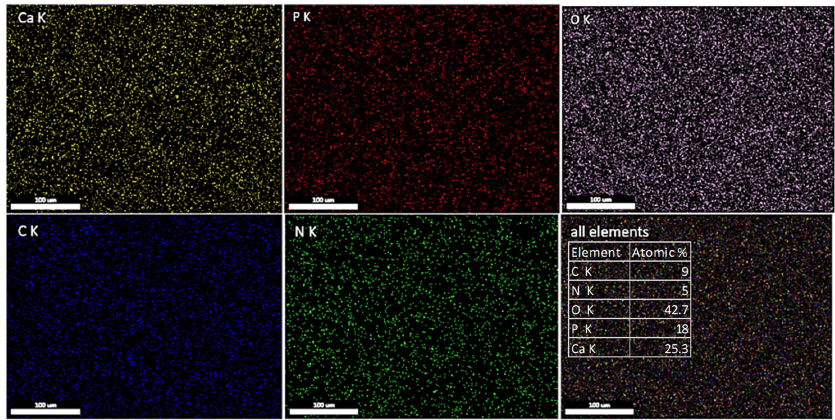
Figure 8. 2D SEM-EDS elemental mapping of the HApCs coating.